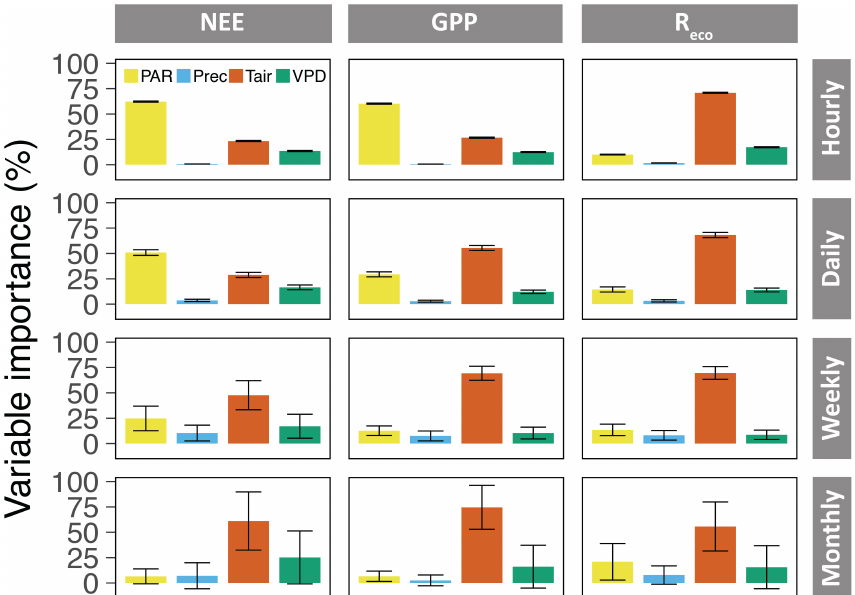
Figure 7. Importance of environmental variables PAR (yellow), T air (orange), Prec (pink) and VPD (green), explaining variability in NEE, GPP and R eco (partitioned by REddyproc) at different temporal aggregations (hourly, daily, weekly and monthly) when all the years were lumped together. Thick bars and error bars represent the mean ± standard deviation of the importance across 1000 decision